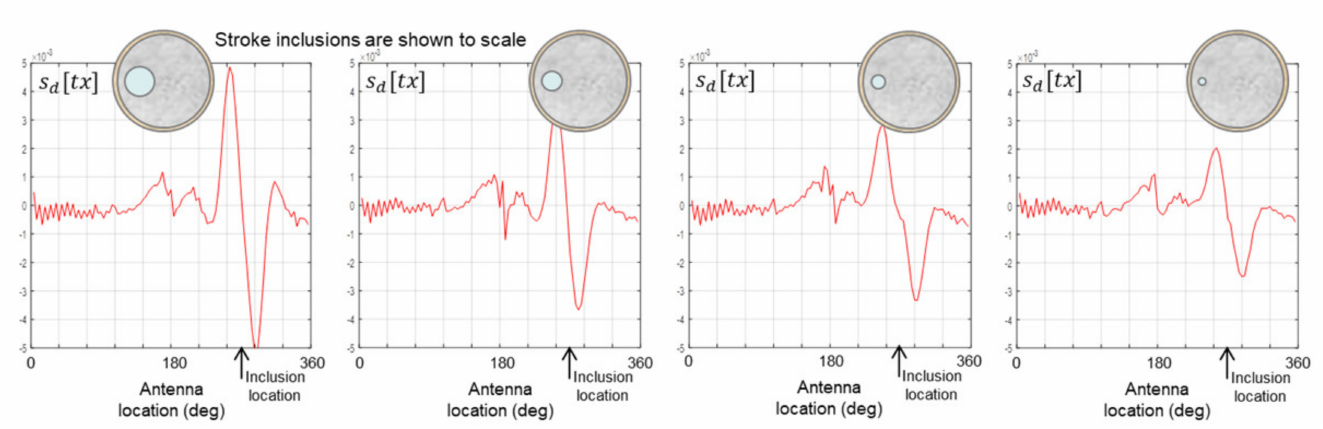
Figure 12. Data from scans of the 175 mm phantom with inclusion sizes of 44 mm ( left ), 30 mm, 21 mm, 11 mm ( right ).